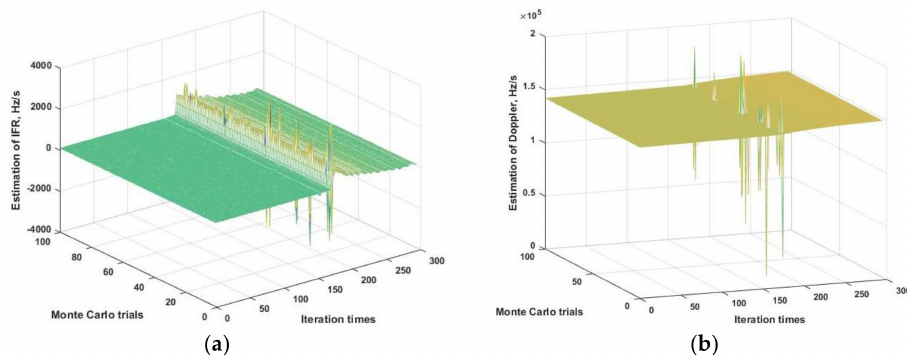
Figure 23. Simulation results of an IFR tracking approach for parachute deployment at CNR = 26 dB-Hz: ( a ) Doppler rate; ( b ) Doppler frequency.